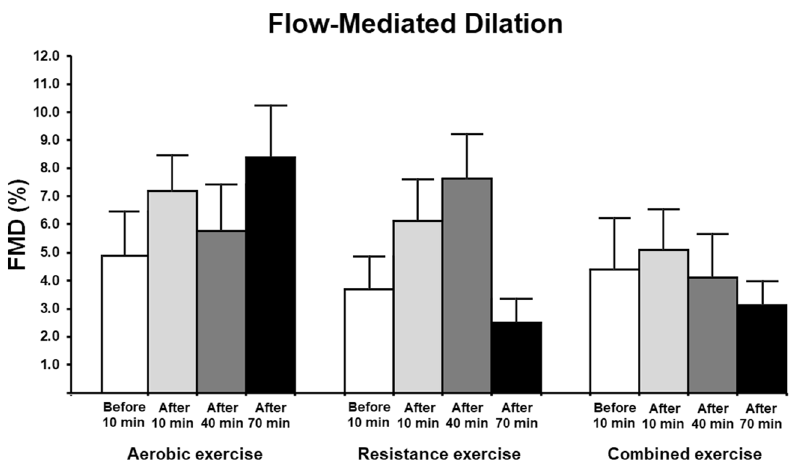
Figure 2. Flow-mediated dilation of the brachial artery at baseline and after the exercise intervention in participants with hypertension. AE: aerobic exercise session (n = 11); RE: resistance exercise session (n = 11); and CE: combined exercise session (n = 10). Values are expressed as mean ± standard error. GEE with Bonferroni post-hoc test was used ( p < 0.05) and no difference was observed within each group and among the groups; p (group) = 0.114, p (time) = 0.263, and p (interaction) =